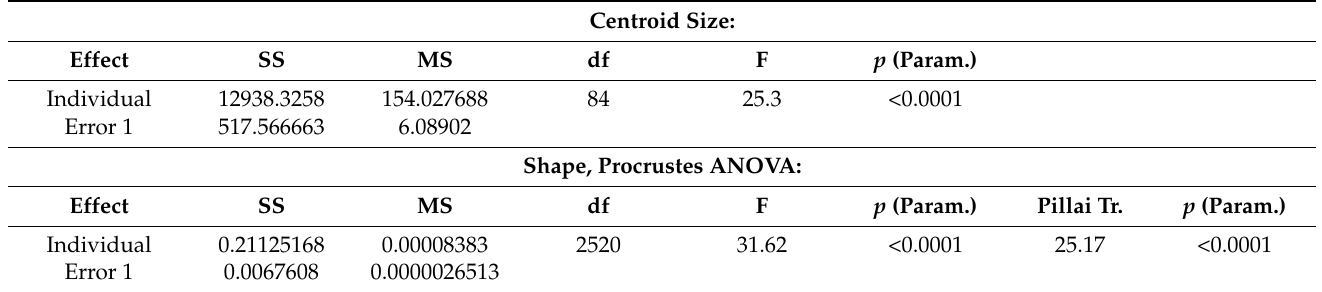
Table 1. Procrustes ANOVA measurement error for Plagioscion magdalenae centroid shape size, with SS (Sum of Squares), MS (Mean Square), df degrees of freedom) and F (F-distribution).